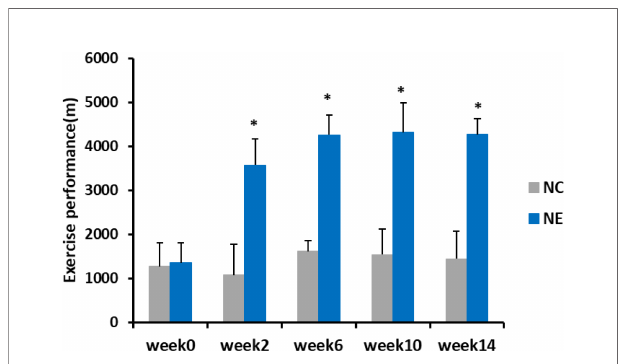
FIGURE 3 | Exercise performance of mice (m). Repeated-measures ANOVA was used to compare the groups. NC = control group; NE = exercise group. Compared with the NC group, *p